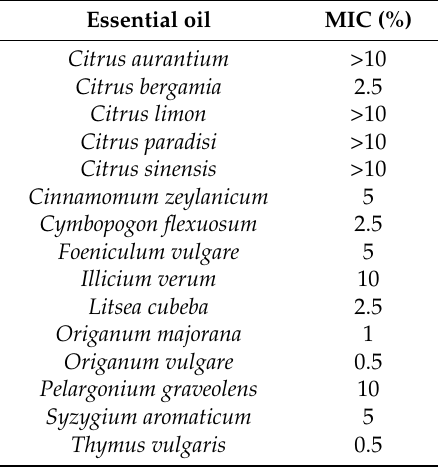
Table 2. Minimum inhibitory concentrations (MIC) of tested essential oils against Saprolegnia parasitica. Essential